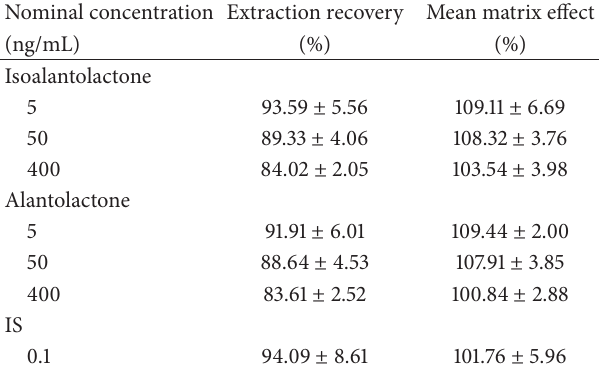
Table 2: Extraction recovery and matrix effect of the method ( 𝑛 = 6